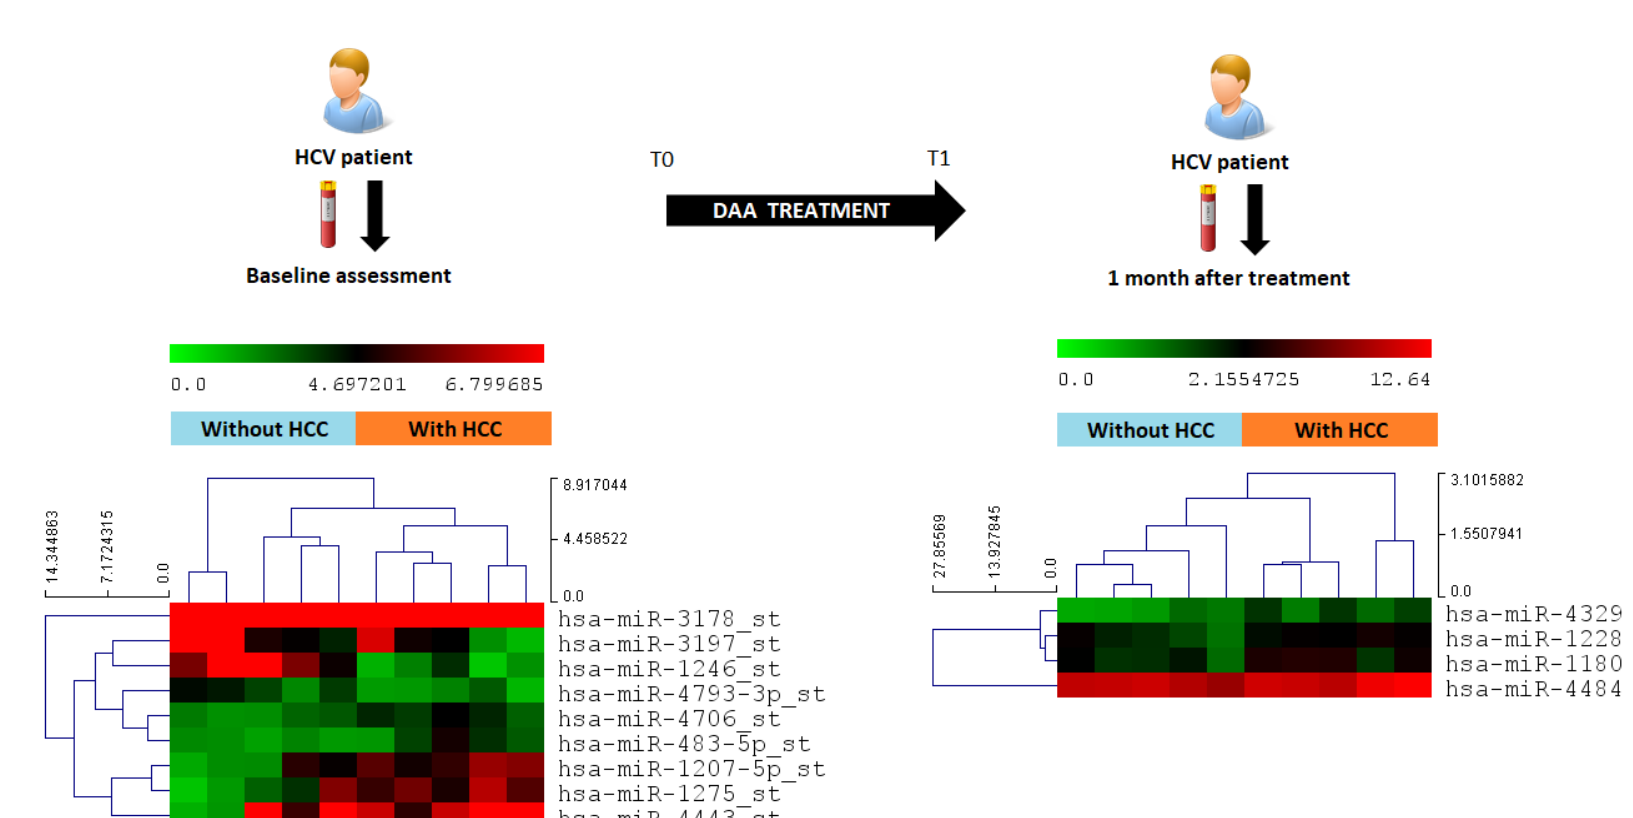
Figure 1. Serum samples were collected from patients before and after DAA treatment initiation. Circulating miRNome profiles were analyzed by miRNA array at both times. Statistically significant miRNAs were included into the heatmap with the pseudocolor scale underneath. Unsupervised hierarchical clustering is used to order samples and miRNAs; the log2-transformed microarray signal was considered. The sample tree with optimized leaf-ordering is drawn using Euclidean distances and average linkages for cluster-to-cluster distances.